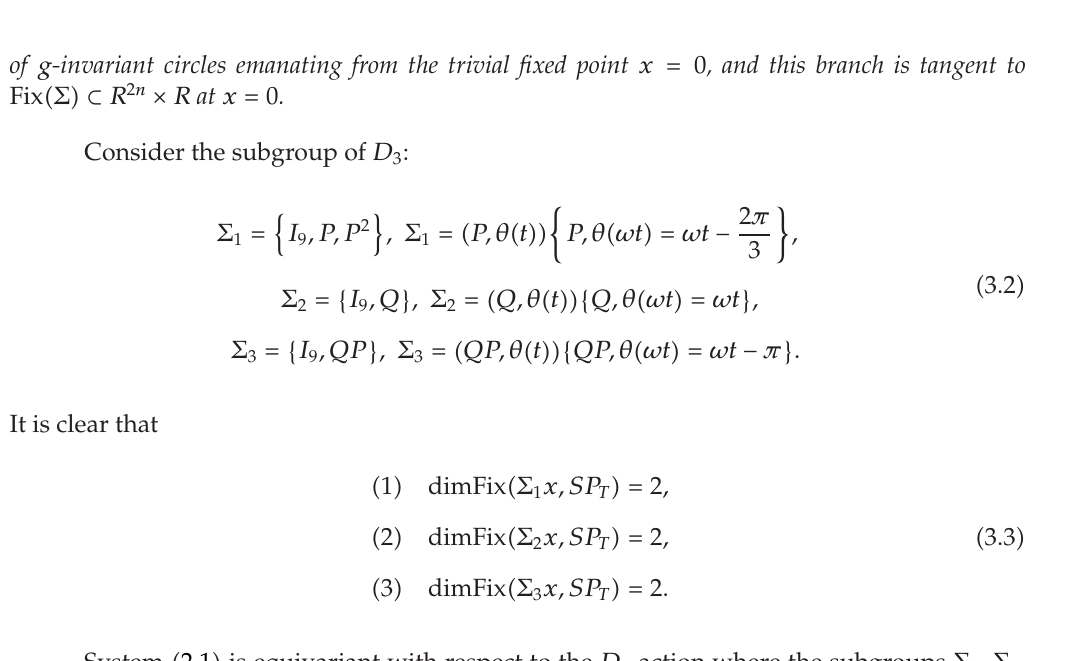
Figure 2: Completely symmetrical periodic solution of (cid:5) x n ,y n (cid:6) ; antisymmetrical periodic solutions (cid:6) , (cid:5) y (cid:6) (cid:5) x n ,z n n ,z n